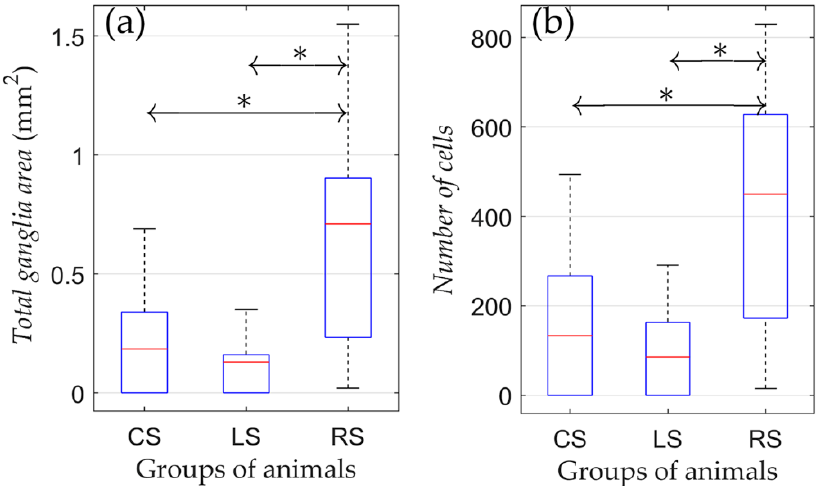
Figure 3. Morphometric parameters of rats that were kept in conditions of natural maintenance after the surgery (no training). ( a ) Total ganglia area and ( b ) number of cells. On each box, the central mark indicates the median, and the bottom and top edges of the box indicate the 25th and 75th percentiles, respectively. The whiskers extend to the most extreme data points not considered outliers. *: p < 0.05.